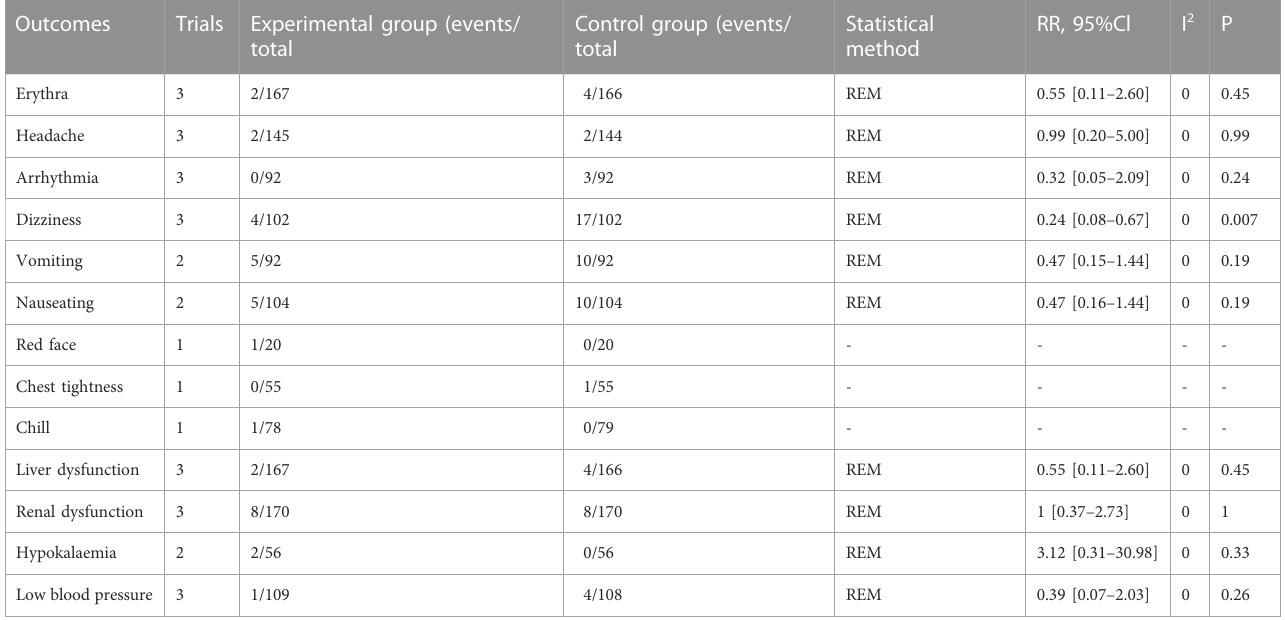
TABLE 4 Adverse reactions and cases between the two groups.